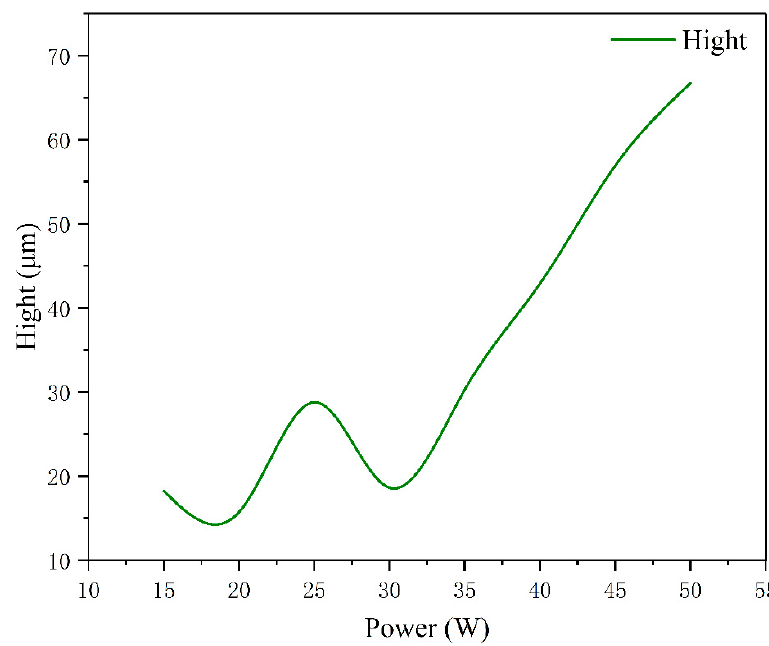
Figure 10. Oxide heights of welded surfaces at different powers.